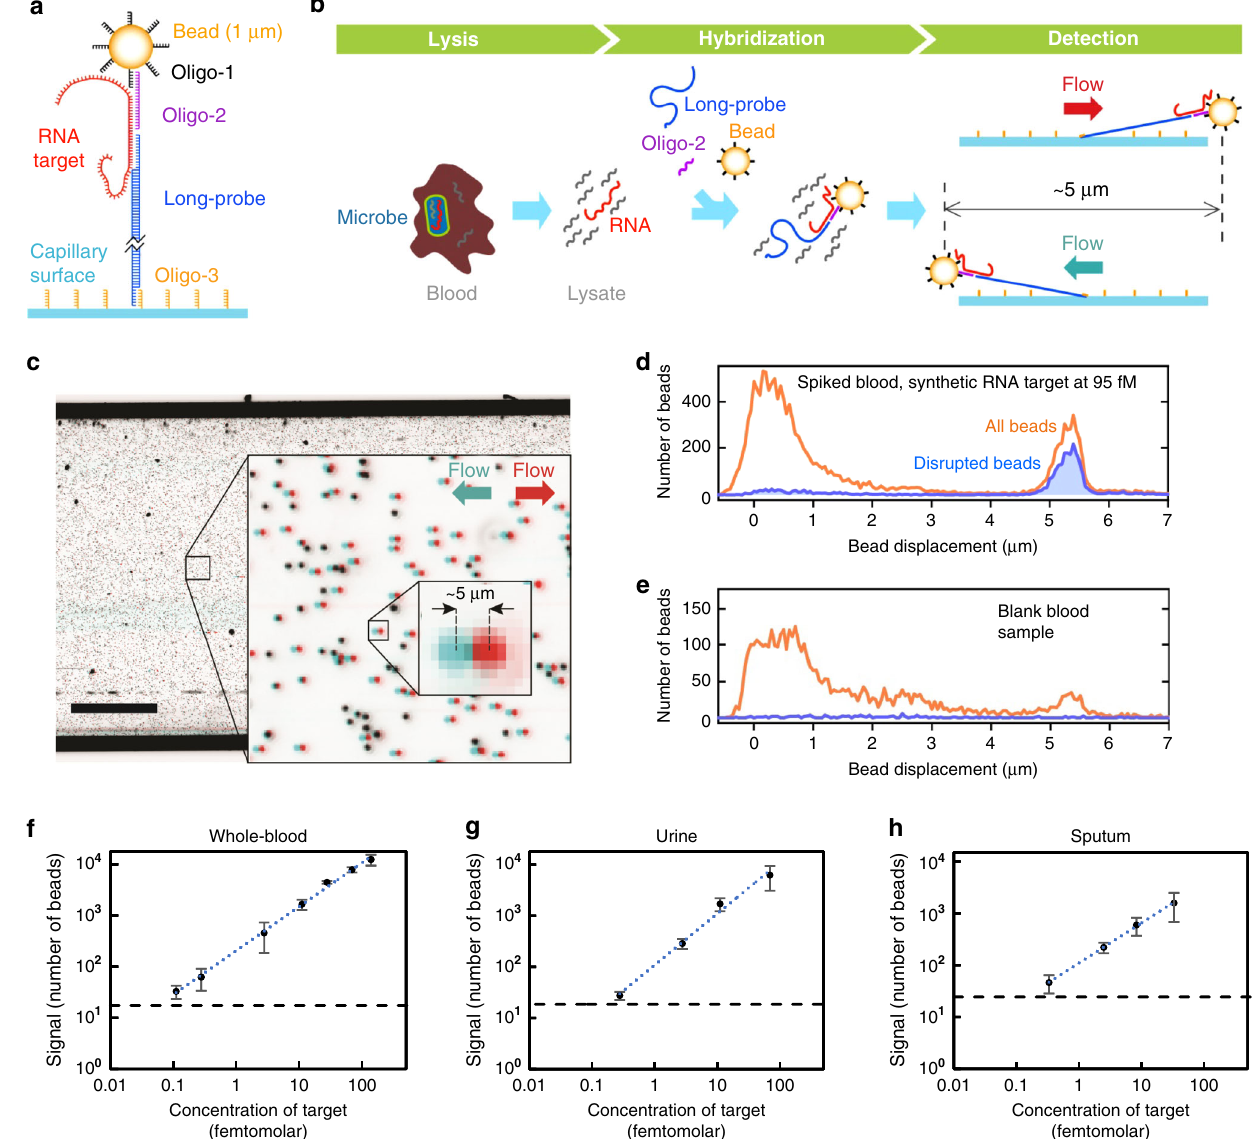
Fig. 1 SMOLT technology design and validation. a SMOLT biosensor design. Superparamagnetic beads are functionalized with a DNA Oligonucleotide (Oligo-1). Oligo-2 has a section complementary to Oligo-1, and a section complementary to the target. The Long Probe (>3 kb pairs) is mostly double- stranded with single-stranded ends. One end is complementary to the target while the other is complementary to an oligonucleotide chemically linked to the capillary (Oligo-3). b The SMOLT assay protocol consists of body fl uid lysis, incubation with probes and beads, and capillary detection where beads are imaged with fl ow in opposite directions. c Superposition of two false-color capillary images exemplify SMOLT bead displacement determination. The red image was obtained with fl ow in one direction and the blue obtained with fl ow in the opposite direction. The displacement of a bead is its change of position between the two images. Non-displaced beads appear black. Similar images were obtained in each bead displacement analysis of this study, n > 200. Scale bar, 1 mm. d , e Histograms of bead displacement. The orange line histograms include the displacement of all the beads in the imaged area. The blue line histograms only include the displacement of disrupted beads (see text). Human whole blood d spiked with target, e not spiked (blank). Detection of synthetic RNA target spiked into human f whole blood, g urine, h sputum. The cutoffs (black dashed line) were de fi ned as the mean plus two times the standard deviation (SD) of blank sample signals in the corresponding body fl uid. The dotted blue line in each panel is a linear function fi tted to the data. Data are represented as mean ± SD. Number of experiments in whole blood were n = 5, 4, 6, 3, 3, 3, 3 for concentrations 0.11, 0.28, 2.77, 11.07, 27.68, 69.19, 138.38fM, respectively. Number of experiments in urine were n = 4, 3, 3, 3 for concentrations 0.27, 2.77, 11.07, 69.19 fM, respectively. Number of experiments in sputum were n = 4, 3, 4, 3 for concentrations 0.33, 2.49, 8.30, 33.21 fM, respectively. Source data are provided as a Source Data fi sputum (Fig. 1f – h and Supplementary Fig. 4). To our knowledge, sub-femtomolar LODs for detection of nucleic acids in body fl uids have been reported only by three methods that do not require enzymatic target ampli fi cation. In contrast to SMOLT, these methods require nucleic acid puri fi cation and long pro- cessing times (6 – 30 h) 13,17,18 . In the context of viremia detection,